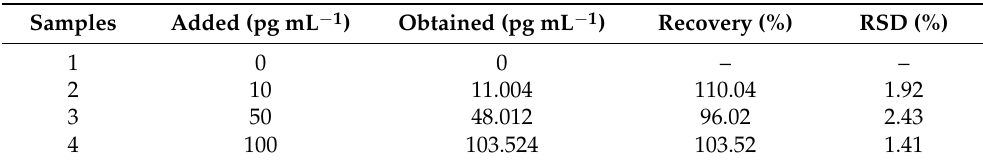
Table 2. The detection of chymotrypsin in the serum ( n =